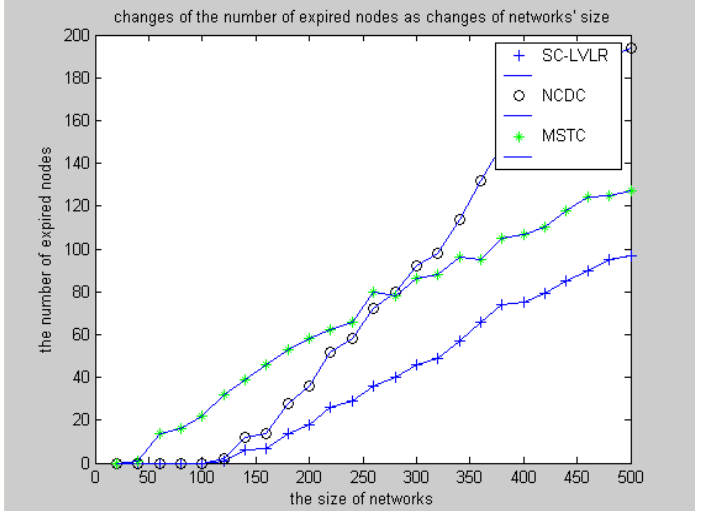
Figure 8. Changes of the number of expired nodes as network size